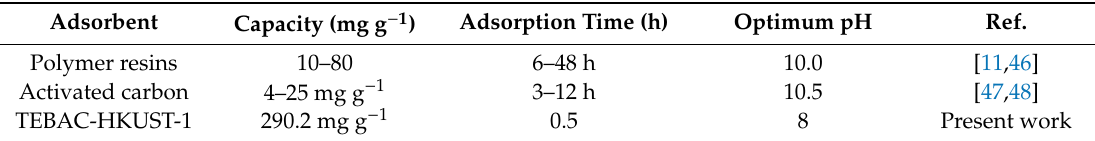
Table 4. Comparison of the maximum adsorption capacity and adsorption time for Pt(CN) 4 2 − with polymer resins and activated carbon.